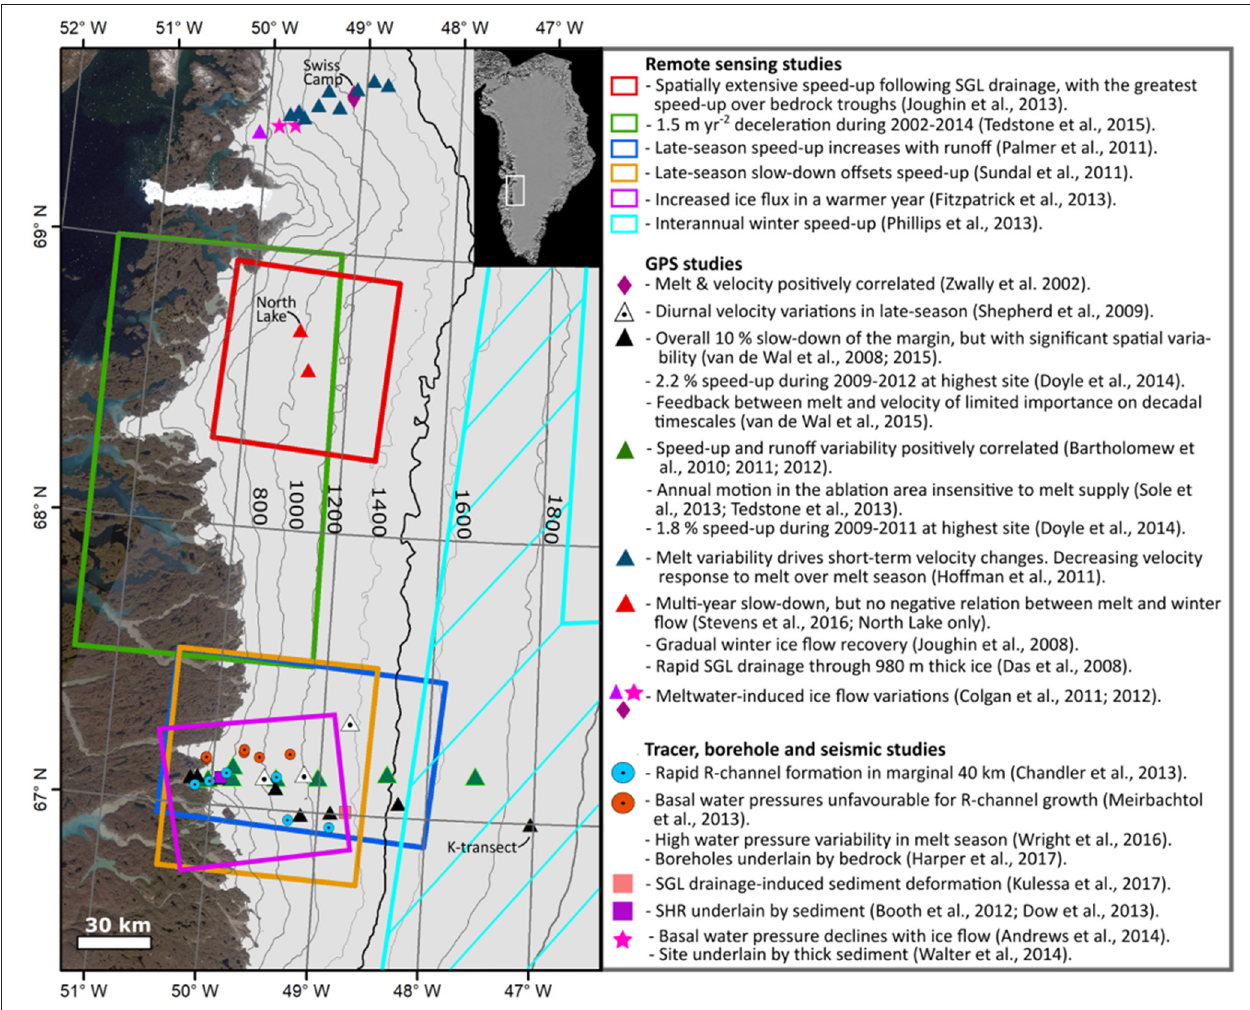
FIGURE 1 | Overview of key observations. Coloured boxes delimit the approximate study area of corresponding text. Also shown are: Swiss Camp (lilac diamond, data presented in Zwally et al., 2002); FOXX and GULL GPS and borehole sites (pink stars, Andrews et al., 2014); K-transect sites (black triangles); Leverett GPS sites (dark green triangles); Russell GPS sites (white dotted triangles, Shepherd et al., 2009); Lake F (pale pink square); moulins used for gas tracer injection (blue dotted circles, Chandler et al., 2013); boreholes presented in Wright et al. (2016) (orange dotted circles). Contours (200m intervals) are from the GIMP DEM (Howat et al., 2014 ), overlaid on a true colour composite Landsat 7 image mosaic (Howat et al., 2014). Inset is a MEaSUREs MODIS mosaic (Haran et al., 2015). The bold contour (1,500m) represents the approximate elevation of the equilibrium line during 1991–2011 [1,553m above sea level in van de Wal et al. (2012)]. “SGL” is supraglacial lake. Note the study area of Phillips et al. (2013) extends off the